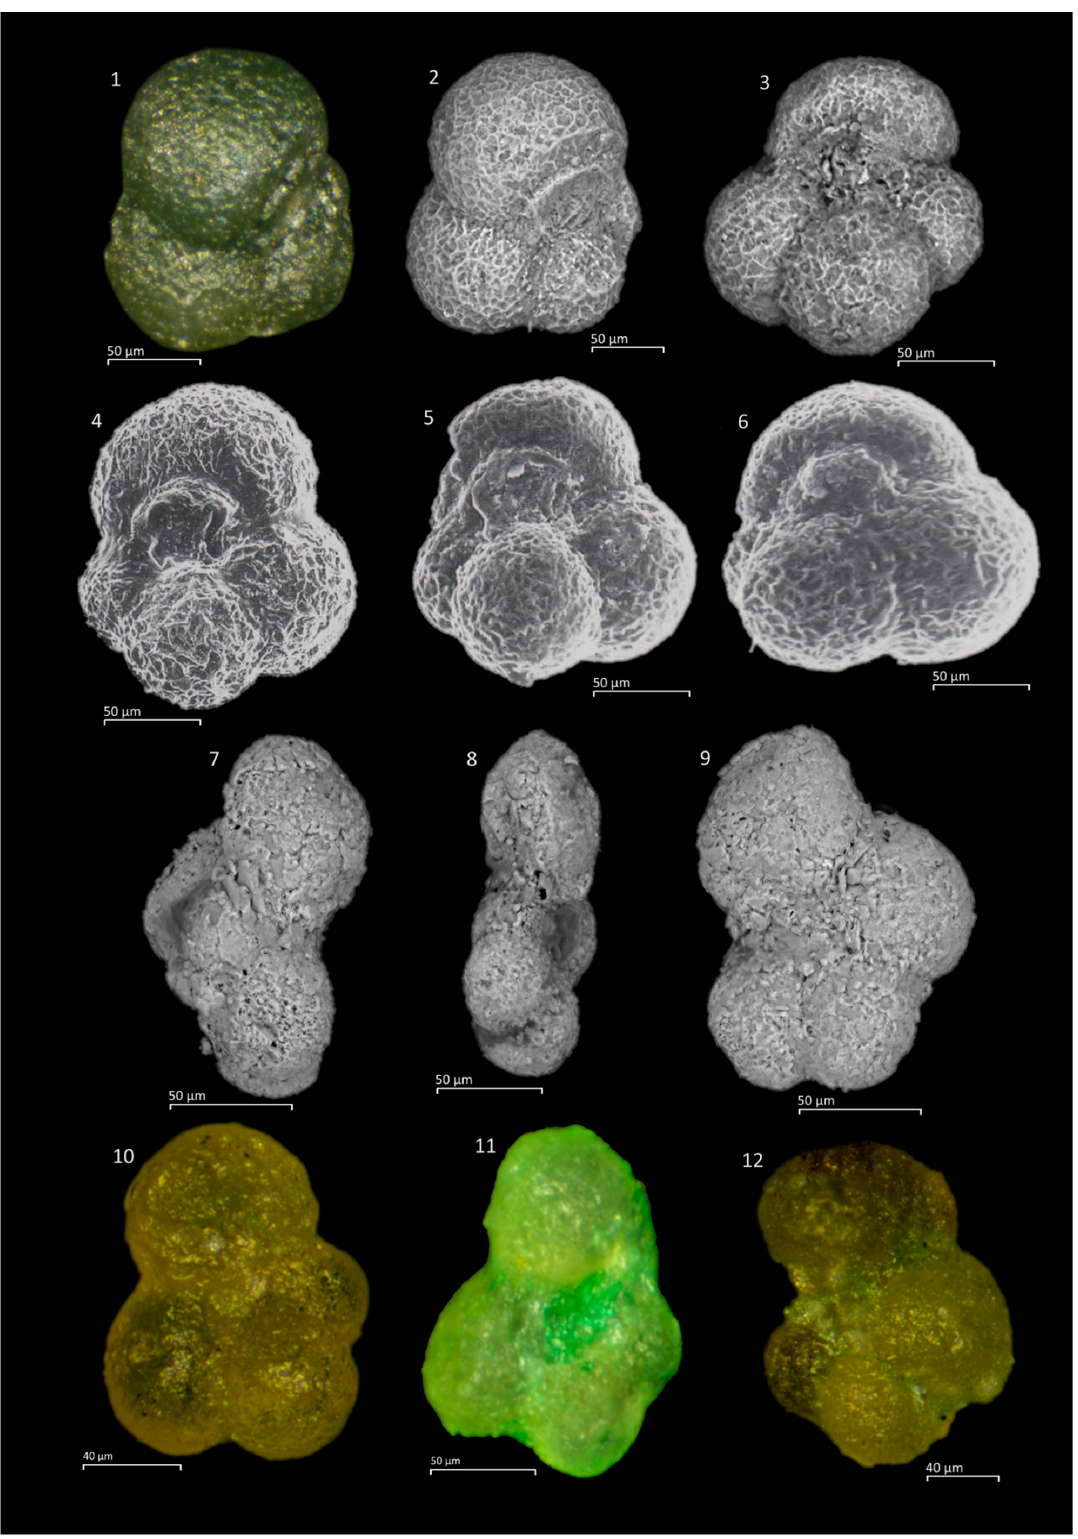
Figure A6. Favusella hoterivica (Subbotina). Subfigures 1 – 6 , Oneida 0–25 well, cts 8760–9460 (cid:48) , Berriasian, E. Canada (Figures 4–6 from Plate II in [47] with permission from the authors). Clavihedbergella eocretacea (Neagu). Subfigures 7 – 12 , sample Cr1 of Berriasian age, Krasnoselivka section, Crimea,